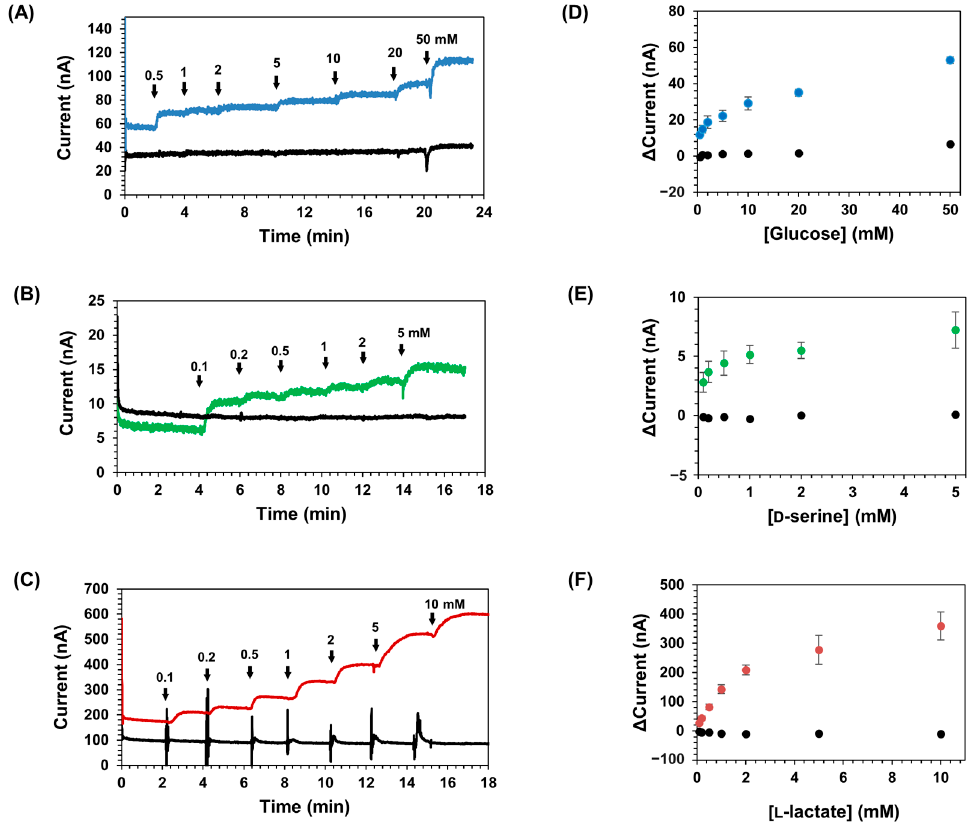
Figure 4. DET property analysis of CYTc-SC/ST-Enzyme complexes-immobilized electrodes by CA measurement. The response curves of electrodes immobilized (A) CYTc-SC/ST-GDH (blue line) and ST-GDH (black line), (B) CYTc-SC/ST-DAAOx (green line) and ST-DAAOx (black line), and (C) CYTc-SC/ST-LOx (orange and red lines) and ST-LOx (black line). The current response after the addition of each substrate was measured continuously by applying 400 mV vs. Ag/AgCl. Arrows indicate the time when substrate solution was added and the final substrate concentration in mM. The plot of measured current response change toward each substrate concentration for the electrodes immobilized (D) CYTc-SC/ST-GDH (blue circles) and ST-GDH (black circles), (E) CYTc- SC/ST-DAAOx (green circles) and ST-DAAOx (black circles), and (F) CYTc-SC/ST-LOx (red circles) and ST-LOx (black circles). All experiments were performed in triplicate. Error bars represent the standard deviation for triplicated